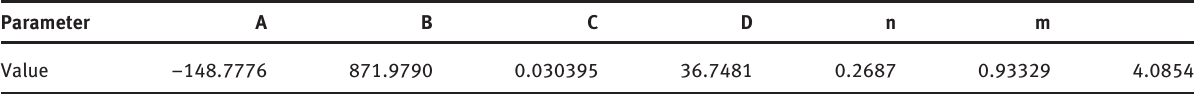
Table 2: Parameters of the original JC model.